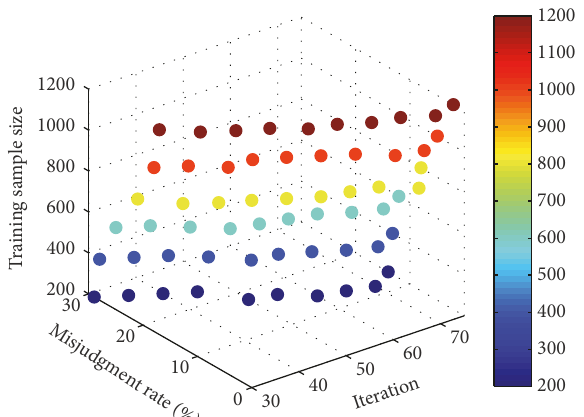
Figure 10: Misjudgment rates of test data.